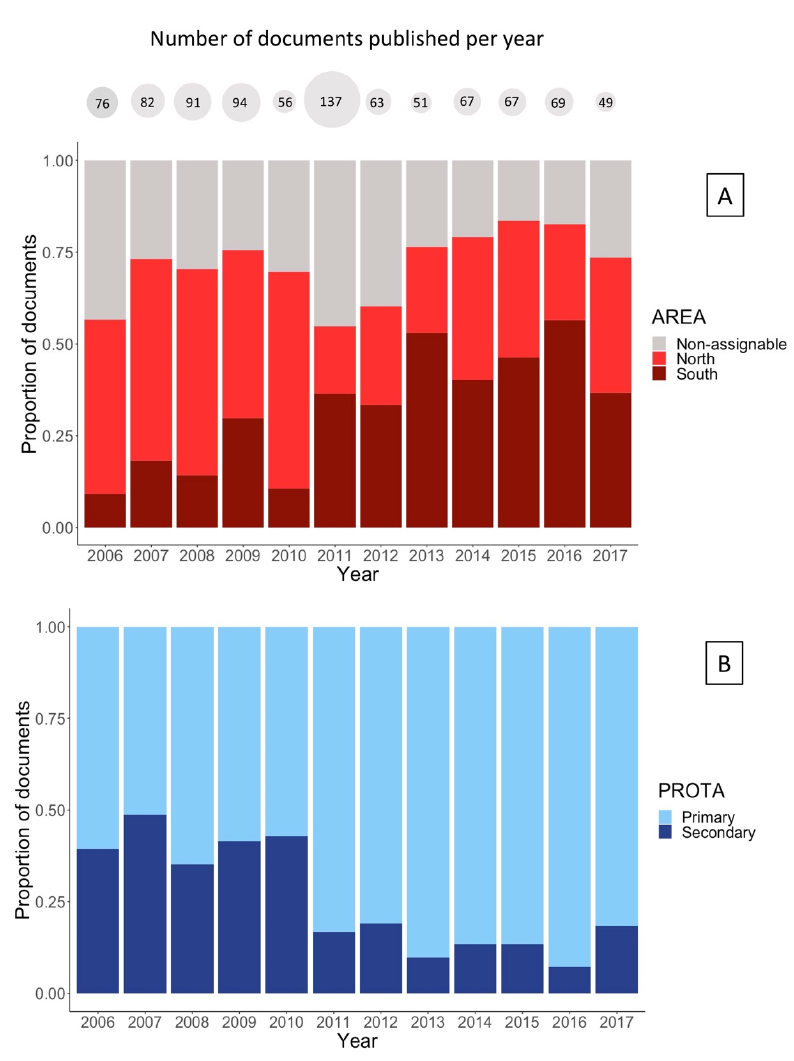
Figure 2. ( A ) Proportion of documents published annually that referred to the three categories of areas considered: north of the River Douro, south of the River Douro, and non-assignable (i.e., larger spatial scales or generic documents). ( B ) Proportion of documents published annually according to whether the wolf was the central theme of the article (primary) or not (secondary). The total number of documents published each year is shown in grey circles above the figure.